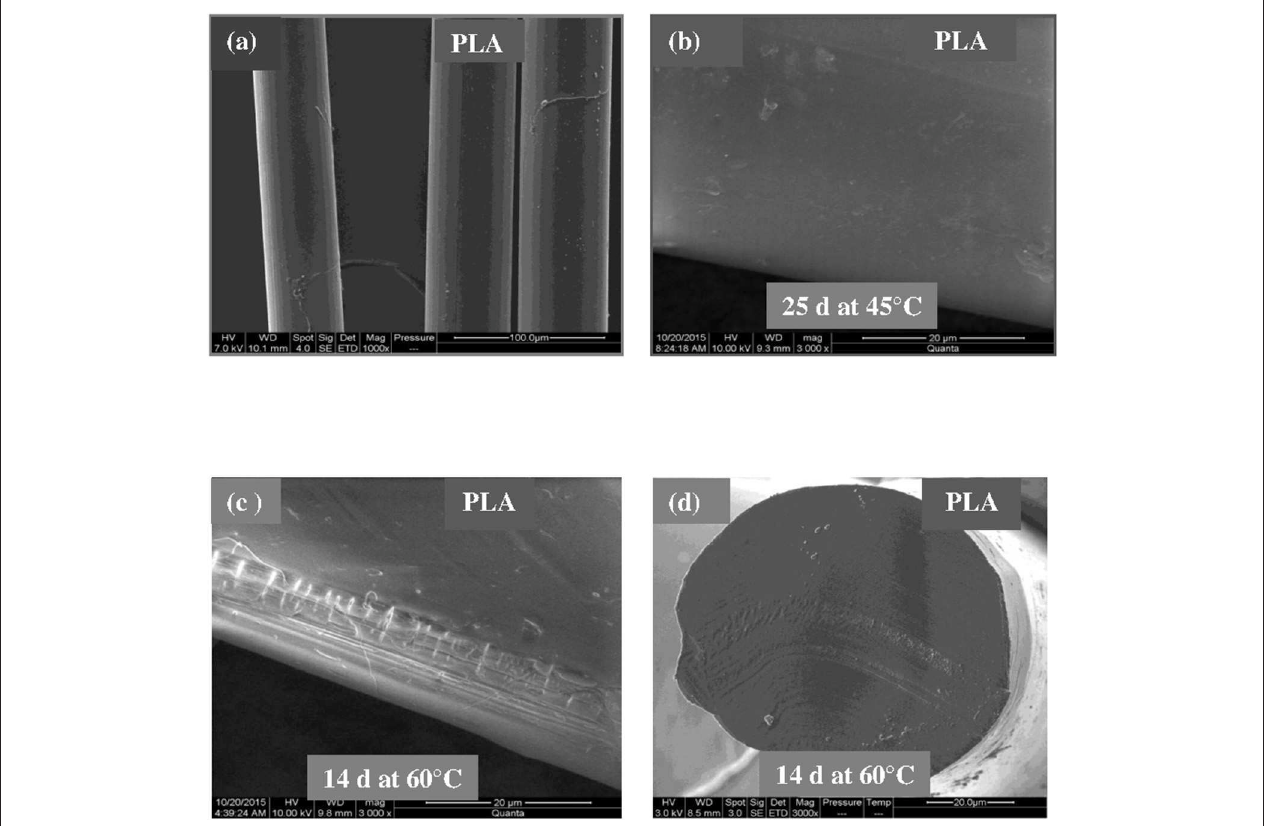
FIGURE 3 | SEM micrographs of external surface of a PLA fiber. (a) Before exposure, (b) after 25 days at 45 ◦ C, (c) after 14 days at 60 ◦ C, and (d) SEM micrograph of cross-sectional surface of a PLA fiber after 14 days at 60 ◦ C.